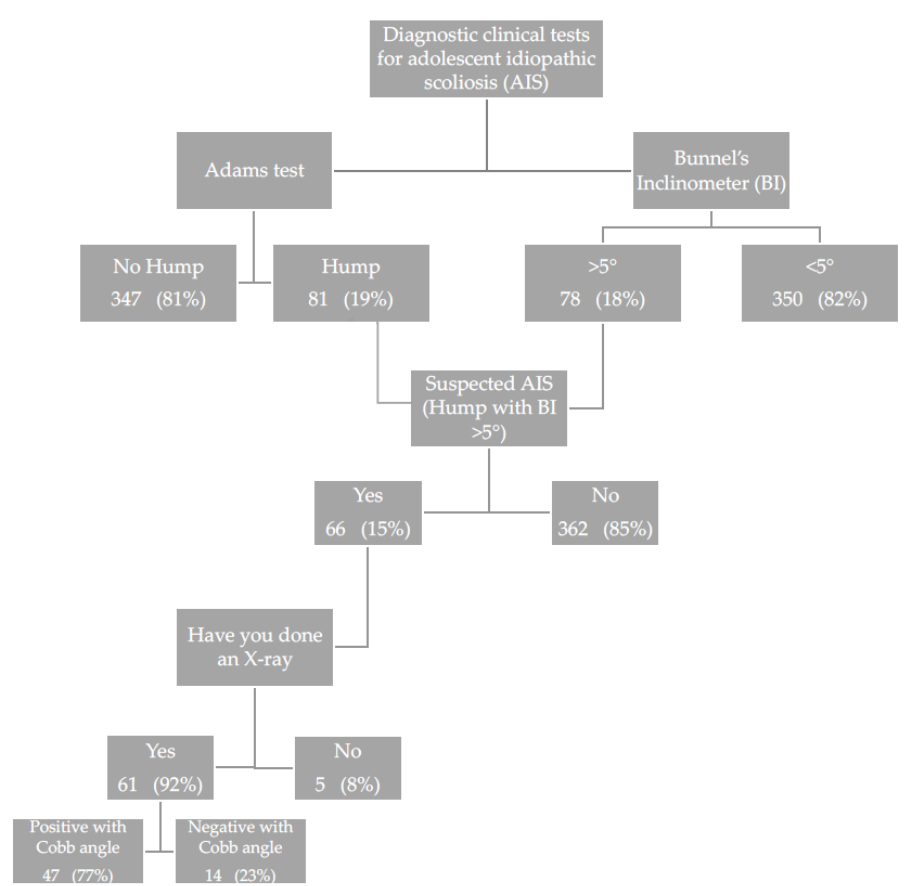
Figure 1. Flow chart of diagnostic clinical tests specific for scoliosis in the study sample ( n = 428). In the end, 47 participants were confirmed with the diagnosis of scoliosis by measuring Cobb angle during an